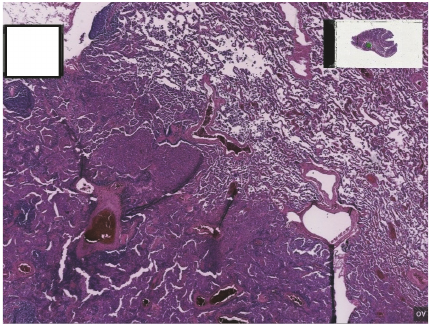
Figure 2: Low power overview showing DIP and RB-ILD with adjacent normal but slightly inflamed lung.